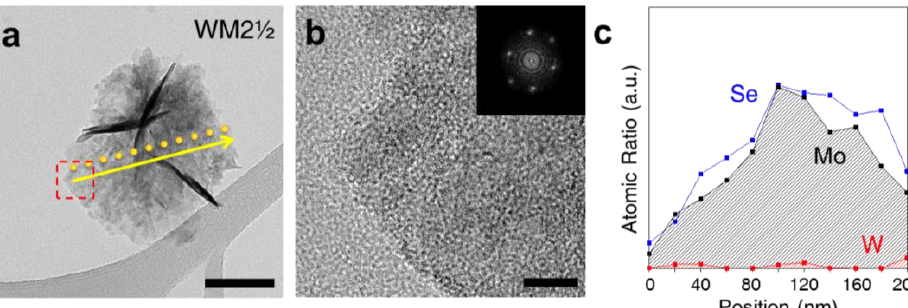
Figure 5. ( a ) Low-magnification TEM image of a nanostructure obtained from 30 min MoSe 2 sec- ondary growth on the WSe 2 nanosheets pre-grown for 2 hrs. Scale bar, 100 nm. ( b ) HRTEM image measured at the edge region highlighted by the dashed red box in ( a ). The inset indicates the corre- sponding FFT pattern. Scale bar, 10 nm. ( c ) Elemental ratio profiles of Mo, W, and Se across the nanostructure, obtained from the point arrays highlighted by the yellow dots in ( a ).